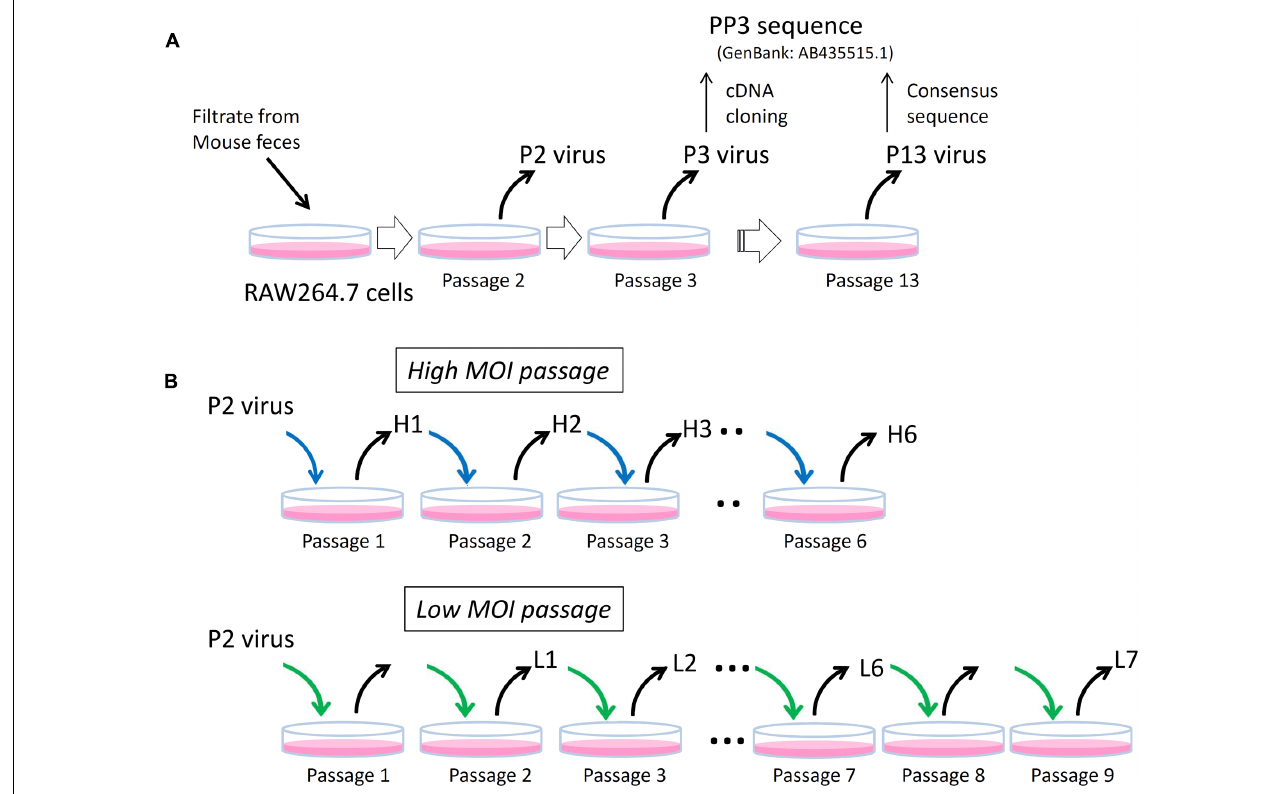
FIGURE 1 | Schematics of experimental layout. (A) P2, P3, and P13 viruses. The P2 and P3 viruses are MuNoV preparations passaged in RAW264.7 cells twice (Passage 2) and three times (Passage 3), respectively. Representative molecular clone of MuNoV S7, PP3, was generated by cDNA cloning from P3 virus. After ten passages of P3 virus (Passage 13), which designated as P13 virus, the consensus sequence of the virus became identical to that of PP3. (B) High and low MOI passages. Two different MOI conditions were used to inoculate P2 virus and subsequent passages in RAW264.7 cells. The blue and green arrows indicate viral inoculation under MOI > 5CCID50 unit and MOI = 1 CCID50 unit, respectively. Note in “Low MOI passage” number of passages and the samples do not match; no viral samples were taken at passages 1 and